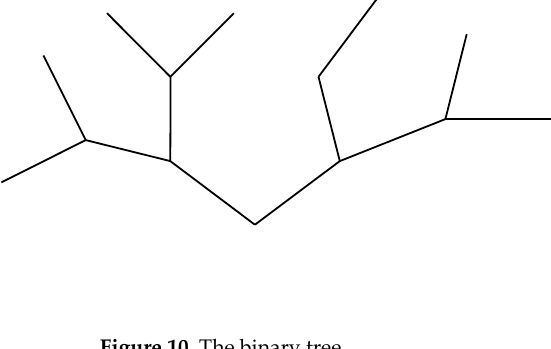
Figure 10. The binary